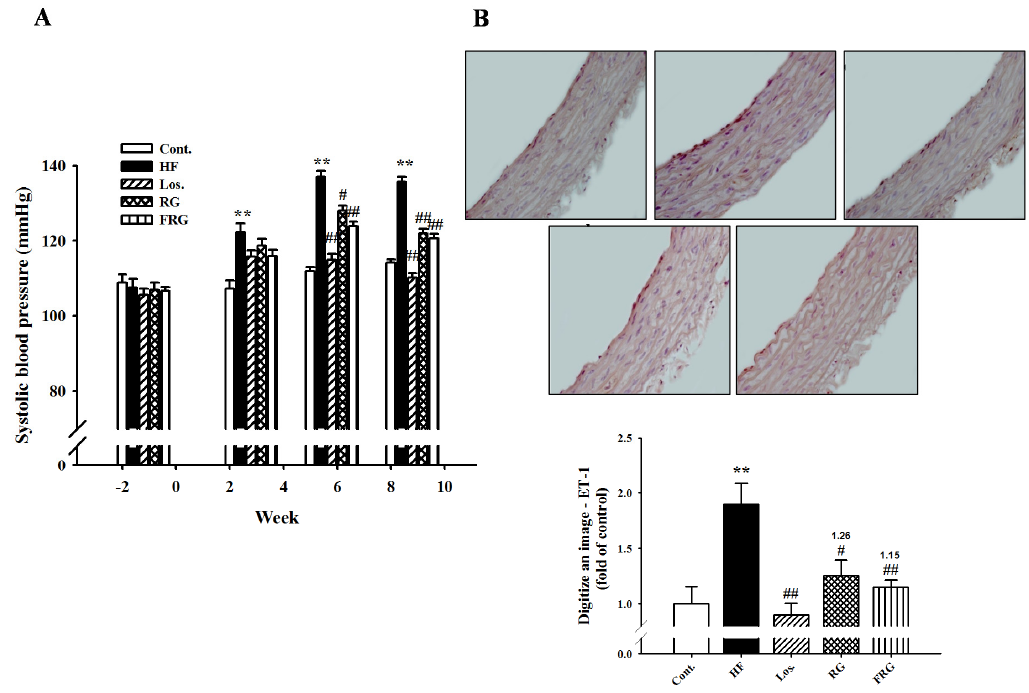
Figure 3. Effects of FRG on systolic blood pressure ( A ) and expression of ET-1 immunoreactivity ( B ) in aortic tissues of HF diet rats. Representative immunohistochemistry and quantifications are shown. Values were expressed as mean ± S.E. n = 10 ( A ) and n = 3 ( B ). ** p < 0.01 versus Cont.; # p < 0.05, ## p < 0.01 versus HF.